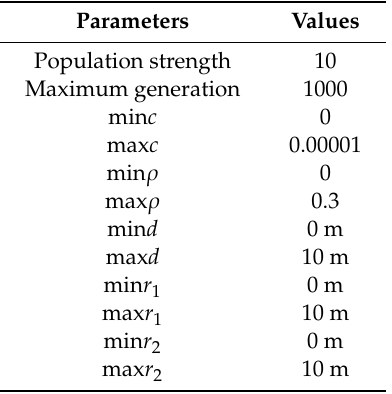
Table 1. The parameters and values in the multi-objective evolutionary algorithm (MOEA).